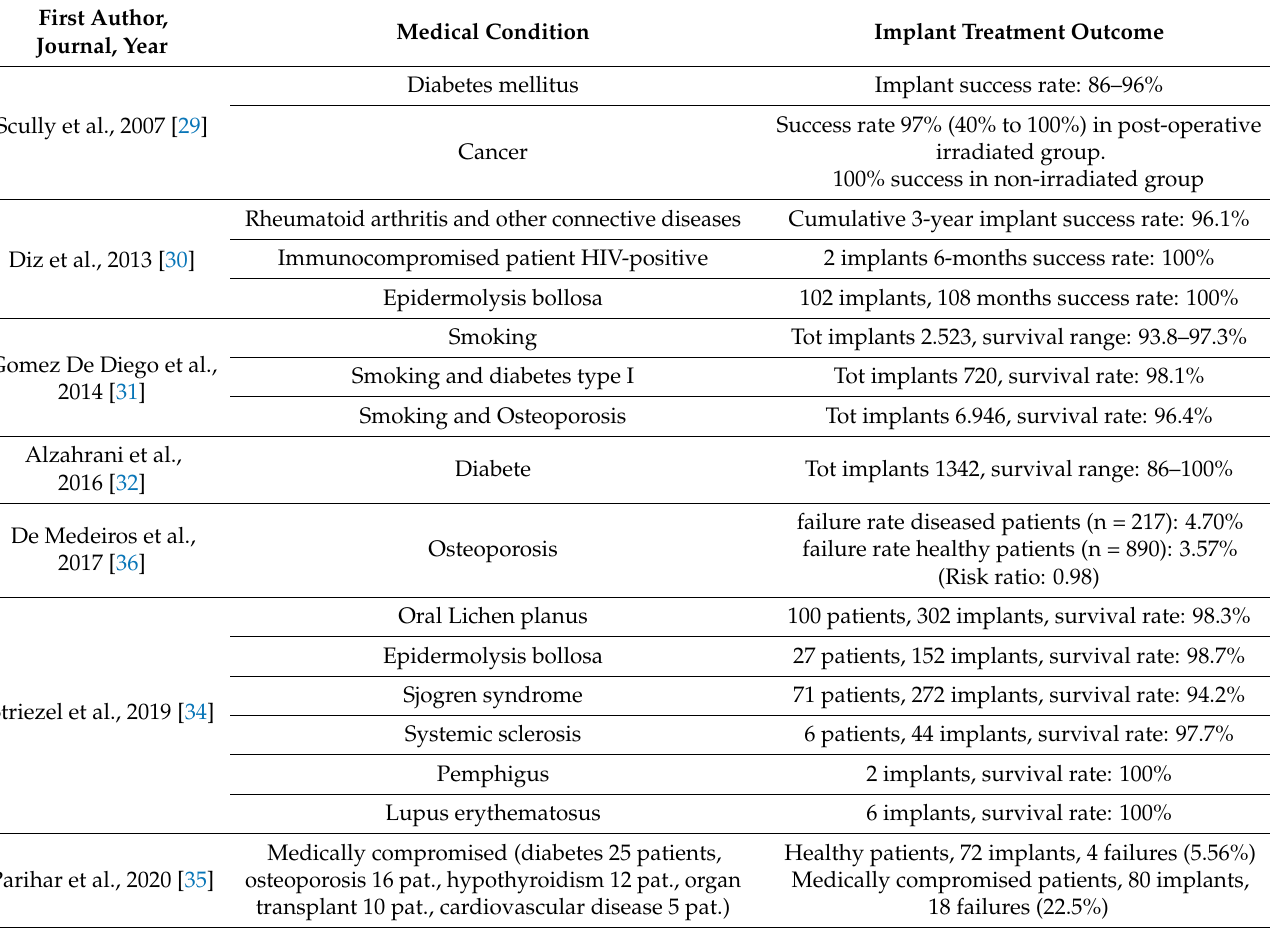
Table 5. Summary of previous studies reporting on implants in medically compromised